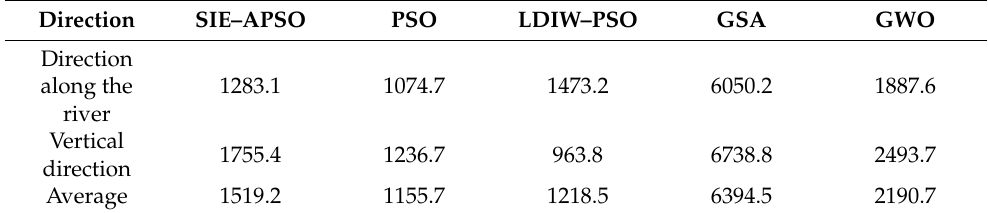
Table 3. Time cost of optimization (unit: